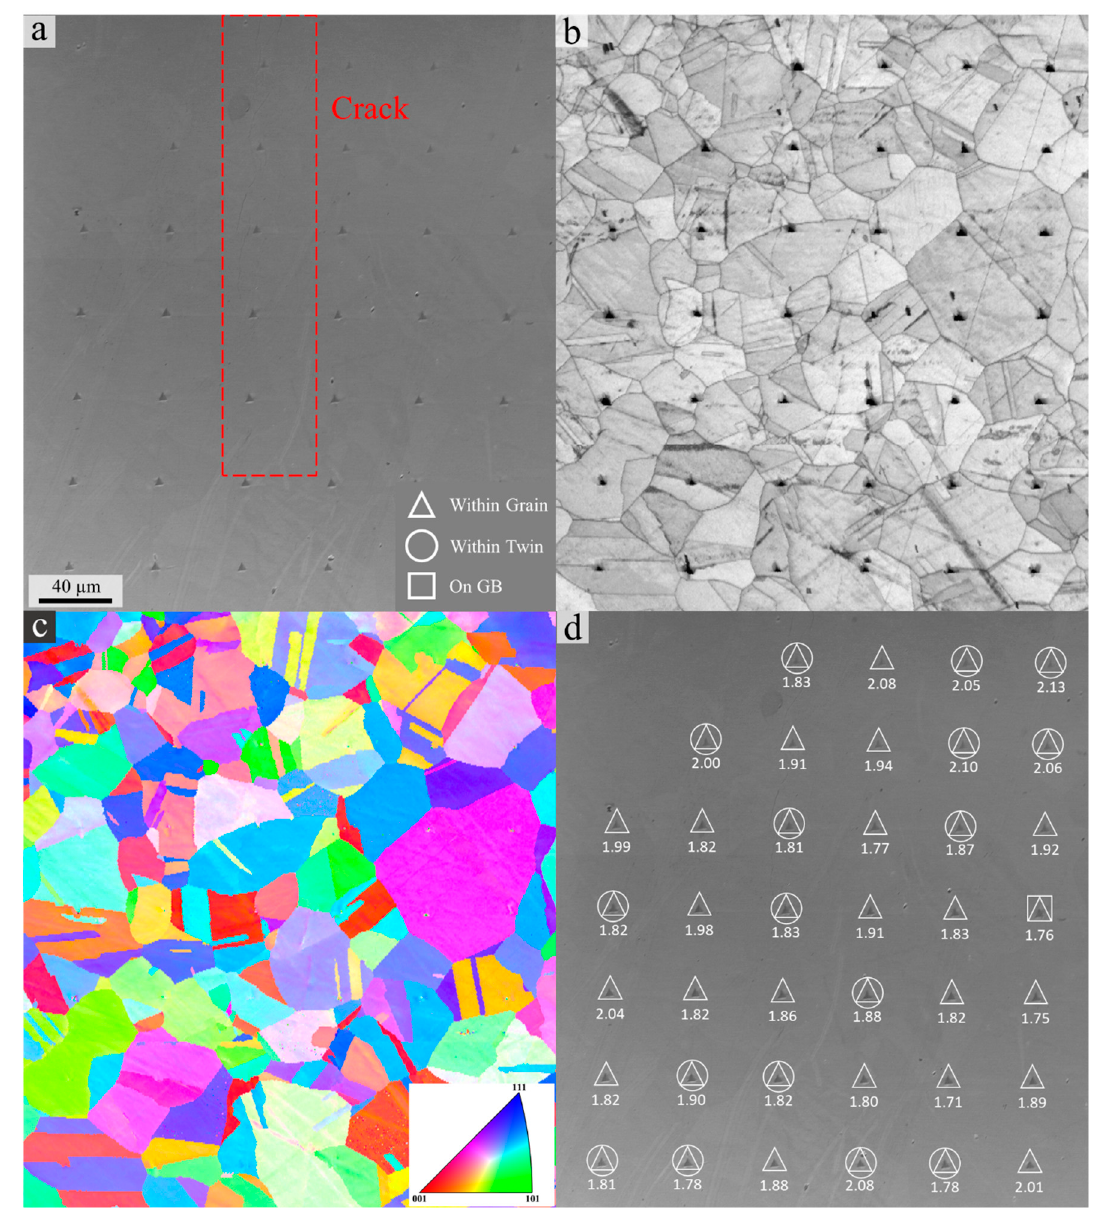
Figure 4. Nanoindentation and EBSD maps of crack #1 region. ( a ) SEM image with crack marked in red; ( b , c ) EBSD-IQ and IPF maps showing the grain structure; ( d ) SEM image annotated with hardness and triangle indentation position, with circle and square marks indicating that the corresponding indent is located on GBs or within a twin, respectively.